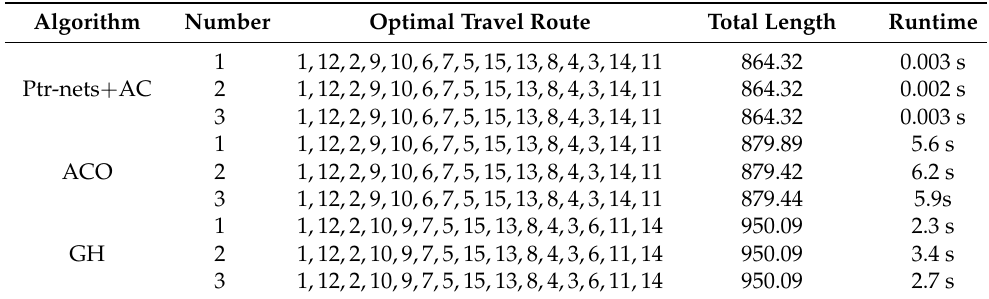
Table 8. Optimal traveling route for the heuristic algorithm, ant colony optimization, and the Ptr-nets+ AC